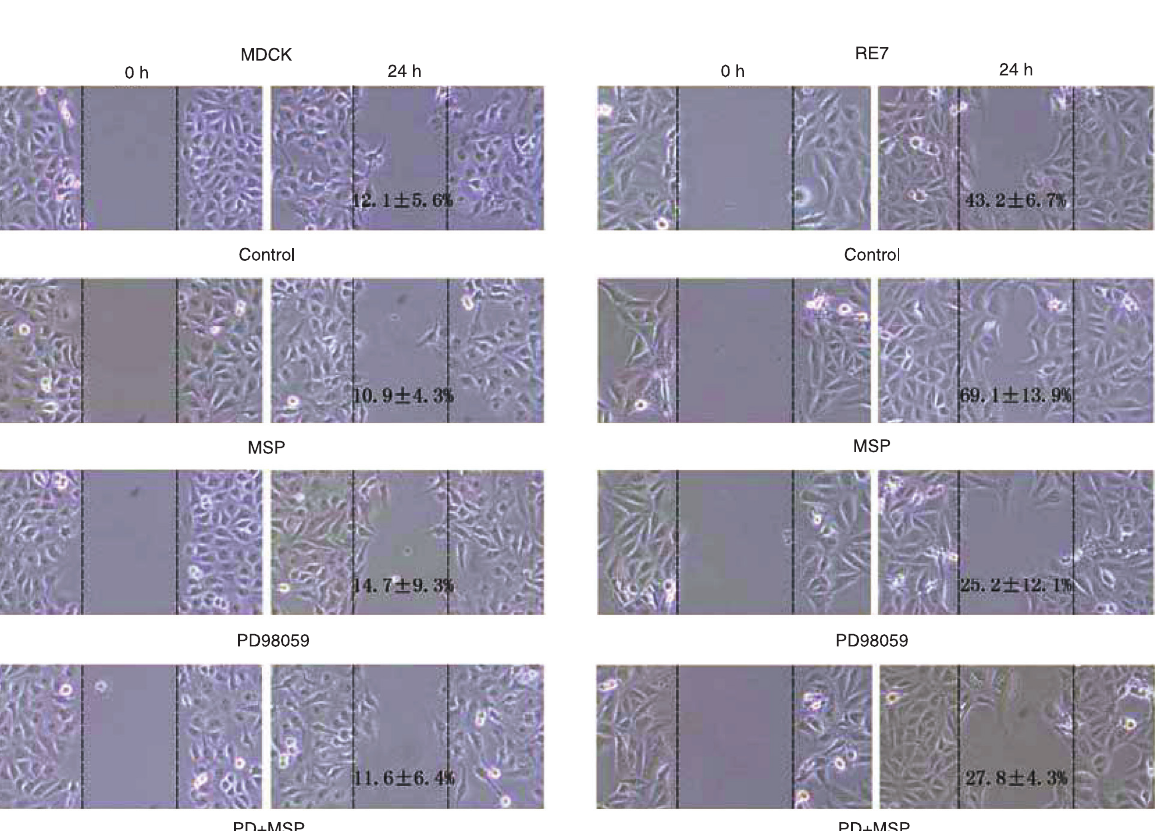
Figure 1. Morphological changes in mac- rophage stimulating protein (MSP)-stim- ulated RE7 cells. Cells (1 x 10 4 cells per well in a 6-well plate) were stimulated with 2 nM MSP for 72 h. The morphologic cell changes were recorded with a light micro- scope (100X). Upon stimulating cells with MSP for 72 h, scatter-like activities were observed as judged by cell-cell dissocia - tion in RE7 cells. Individual cell morpholo - gies were also altered dramatically with elongated shapes and a rounded appear- ance.